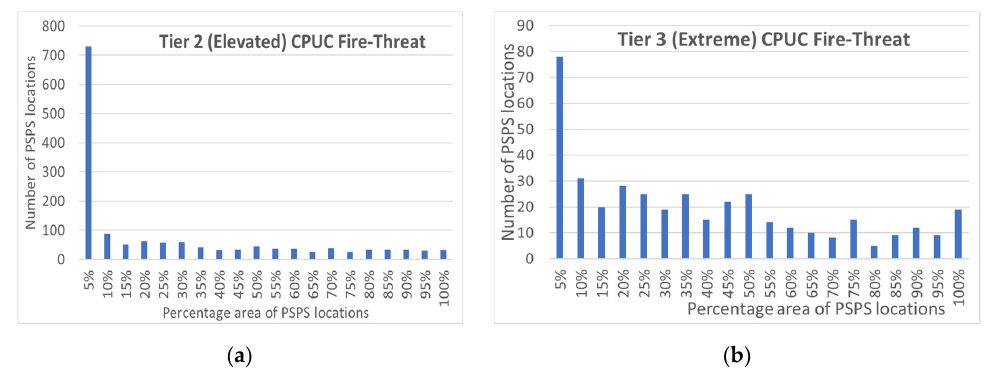
Figure 6. Percentage of the areas of PSPS locations that are under ( a ) Tier 2 (Elevated) or ( b ) Tier 3 (Extreme) Fire-Threat according to the California Public Utilities Commission (CPUC).